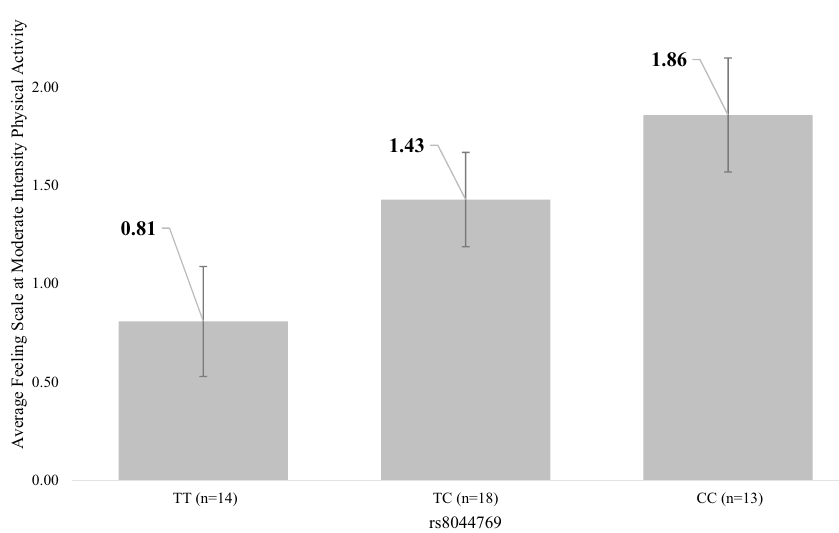
Figure 2. FTO SNP rs8044769 and Average Feeling Score at Moderate Intensity Physical Activity based on adjusted regression model in Table 1. The predicted mean value from a multivariate regression model, in which average Feeling Scale report during moderate intensity physical activity was regressed on FTO SNP, rs8044769, adjusting for Feeling Scale report before physical activity, age, sex, race, and body mass